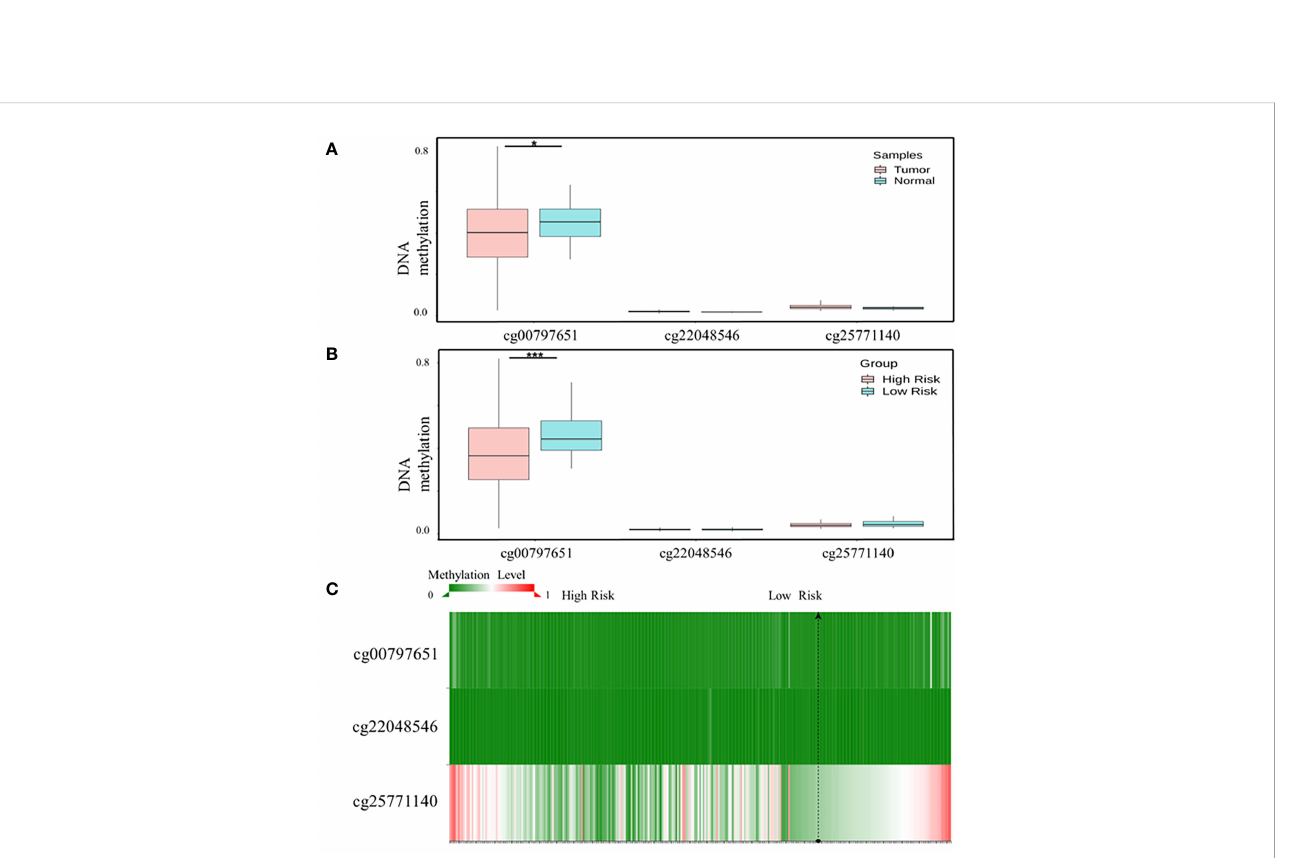
FIGURE 5 Methylation modi fi cation of CD55 promoter in colon cancer. (A) The cg sites of CD55 promoter region in COAD by SurvivalMeth. (B) The methylation level of CpGs in high- and low-risk groups. (C) The heatmap of three cg sites and their methylation level (* p < 0.05, *** p < 0.001). COAD, colon adenocarcinoma.